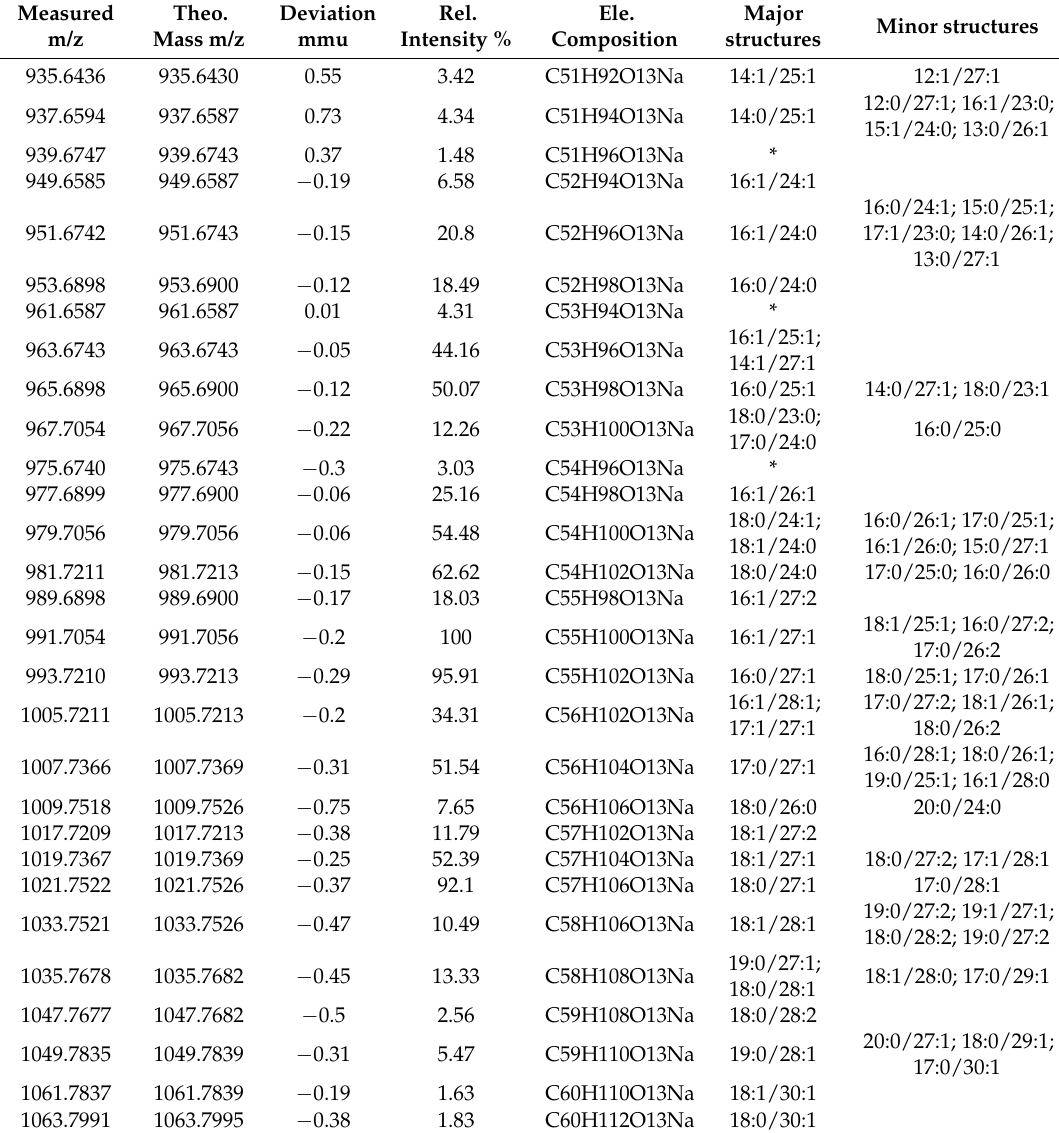
Table 1. The high resolution mass measurements of the [M + Na] + ions of DATs isolated from M. tuberculosis and the assigned structues (* structure not